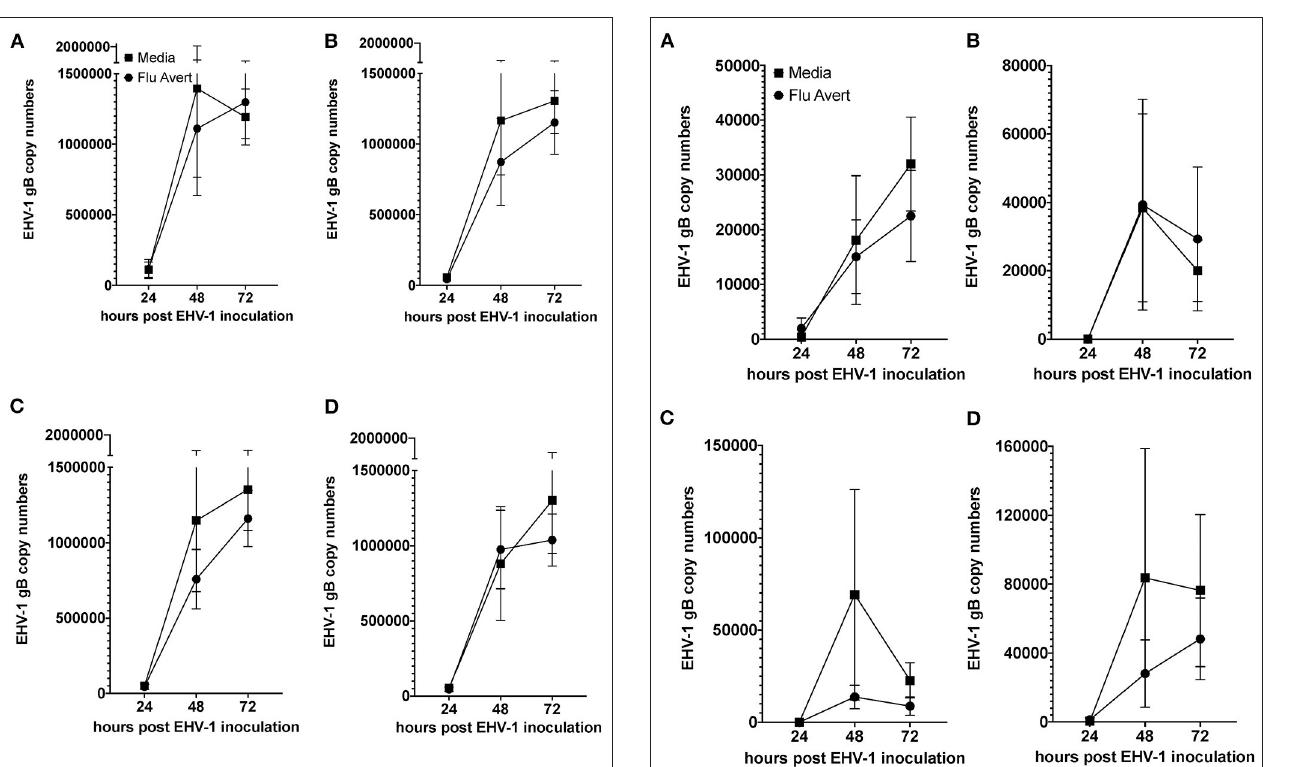
FIGURE 2 | Mean ± SEM difference in intracellular EHV-1 copy number between Flu Avert-treated and media-treated ERECs from five horses. (A) Intracellular copy number in ERECs treated with Flu Avert or media on day 1 prior to EHV-1 inoculation. (B) Intracellular copy number in ERECs treated with Flu Avert or media on day 2 prior to EHV-1 inoculation. (C) Intracellular copy number in ERECs treated with Flu Avert or media on day 5 prior to EHV-1 inoculation. (D) Intracellular copy number in ERECs treated with Flu Avert or media on day 7 prior to EHV-1 inoculation.